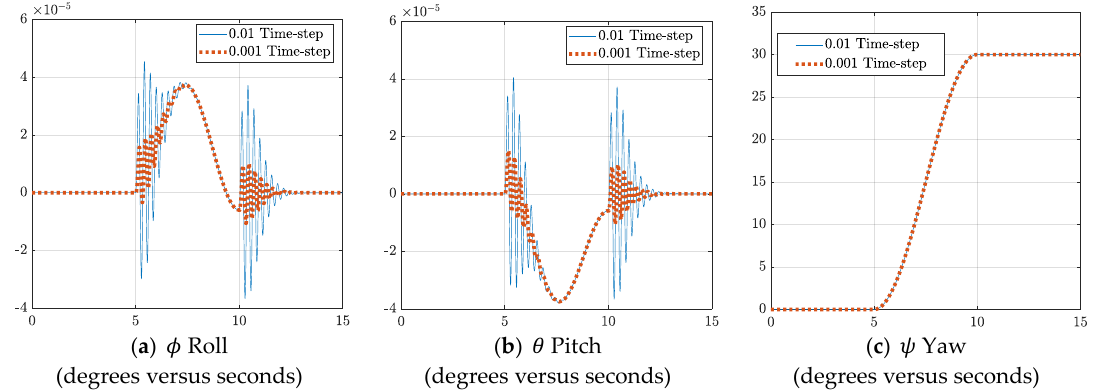
Figure 4. Time-step analysis for the ϕ , θ , and ψ Euler angles for two disparate time-steps with deterministic artificial intelligence. Pay particular attention to the near coincident performances when viewed in large-scale in Figure 4c, while the smaller-scaled plots reveal differences.